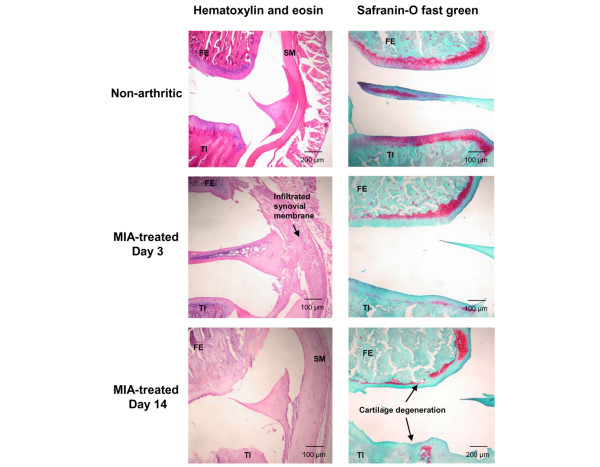
Histological analysis of synovial tissue and articular cartilage pre- and post-monosodium iodoacetate (MIA) injection. Time course of histological changes of the rat knee before and days 3 and 14 after MIA injection. Left sections of the medial aspect of rat knee joints were stained with hematoxylin and eosin, right sections with safranin-O fast green. In non-arthritic rats no abnormality is present. On day 3 after MIA treatment the hematoxylin and eosin stained sections show significant expansion of the synovial membrane with a large amount of cellular infiltrate. No inflammation can be seen on day 14 post-MIA injection. The sections stained with safranin-O fast green reflect major cartilage degeneration on day 14 post-MIA injection. SM, synovial membrane; FE, femur; TI, tibia.